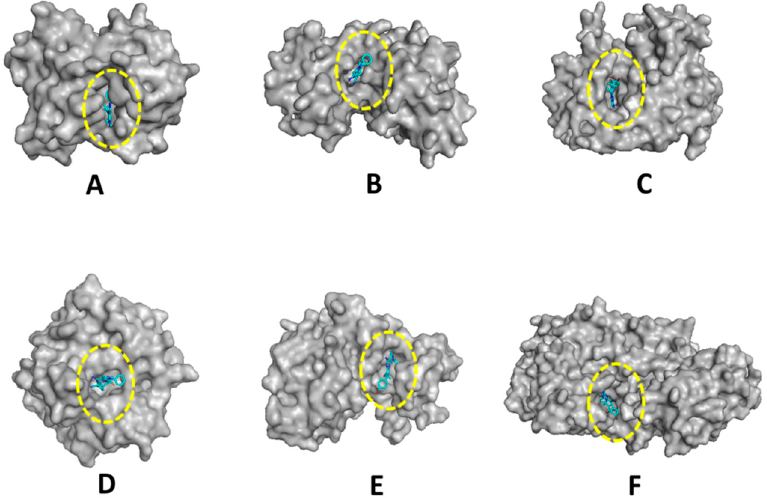
Figure 4. The surface representation of enzymes ( A ) DHFR, ( B ) VEGFR2, ( C ) HER-2, ( D ) hCA-IX, ( E ) CDK6 and ( F ) LOX5 in gray, and the sticks represent (cyan) the docked compound 7e .